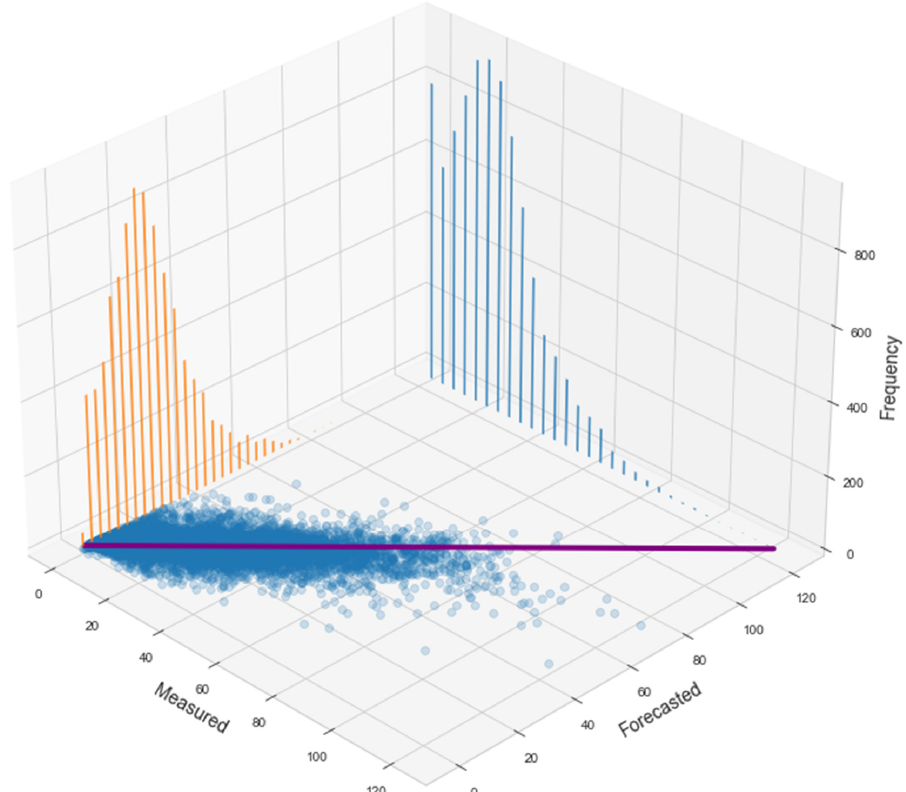
Figure 14. Scatter plot with marginal distribution for GraphSAGE model forecasting ozone 6 h ahead.